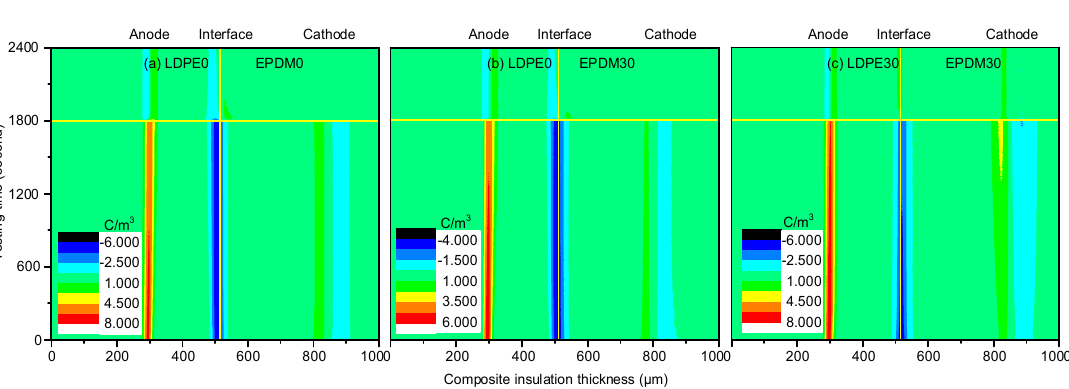
Figure 7. Space charge distribution during the polarization and depolarization processes. ( a ) LDPE0/EPDM0; ( b ) LDPE0/EPDM30; and ( c ) LDPE30/EPDM30.